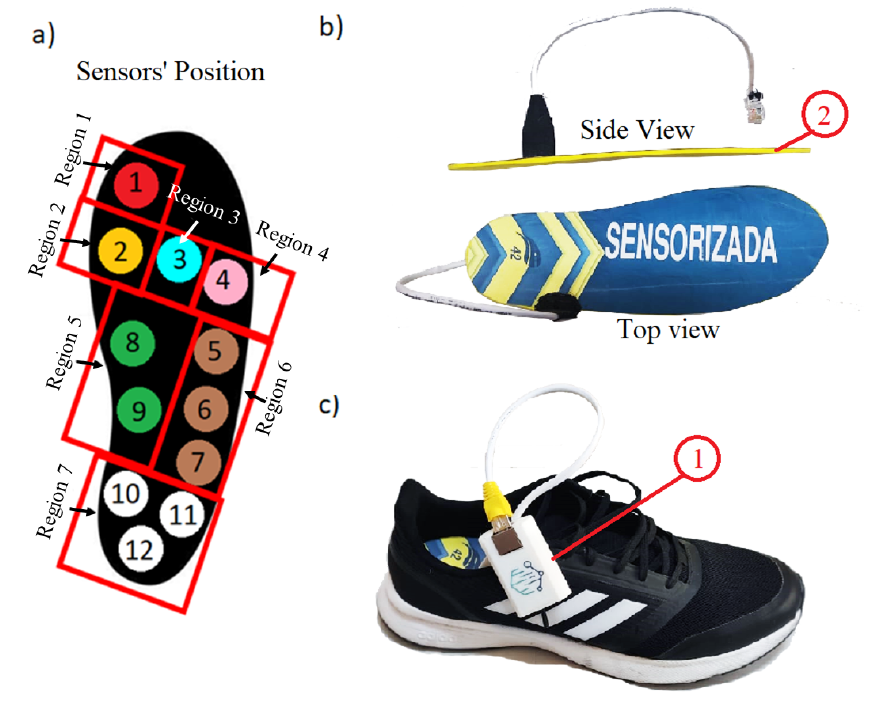
Figure 1. ( a ) Visualization of the seven regions of sensors with 12 sensors in total. ( b ) Visualization of the finished sensorized insole. The picture also shows the EVA base of the insole (2). ( c ) Visualizing the compact sender device (1) that connects with a sensorized insole using an RJ45 connector. Seven regions were chosen to include the sensors according to the foot anatomy [20,36], and each region also has a relationship with the gait phases and their positions, which permits us to observe some behaviors of the following regions: posterior calcaneus (three sensors)—this region is the most important region to record loading response (first phase of gait); medial midfoot (navicular bone, two sensors) and lateral midfoot (cuboid